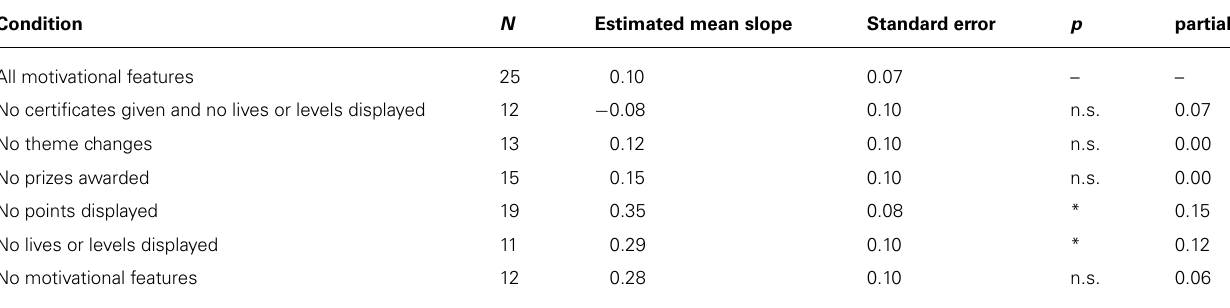
Table 2 |Training improvement by game variant.